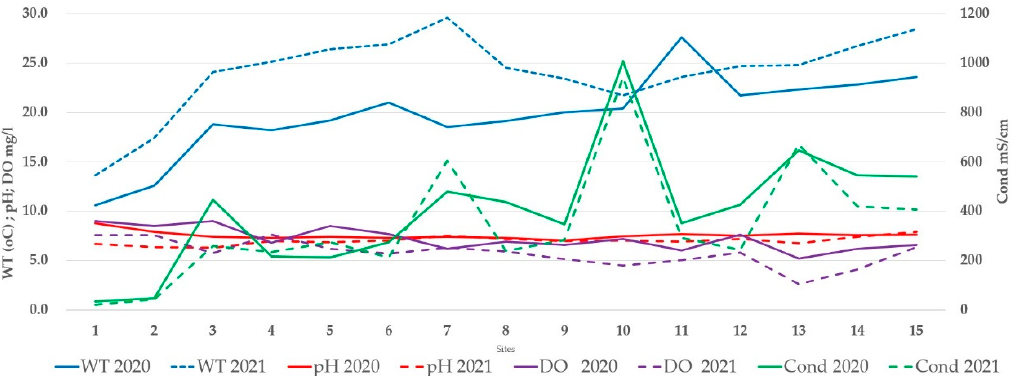
Figure 2. Dynamics of the WT, pH, COND and DO values at the studied sites in 2020 and 2021. Phosphates and especially nitrates showed considerably higher concentrations in 2021 compared with 2020 (Figure 3). The values of nutrients remained almost unchanged only at the two referent sites (1 and 2).